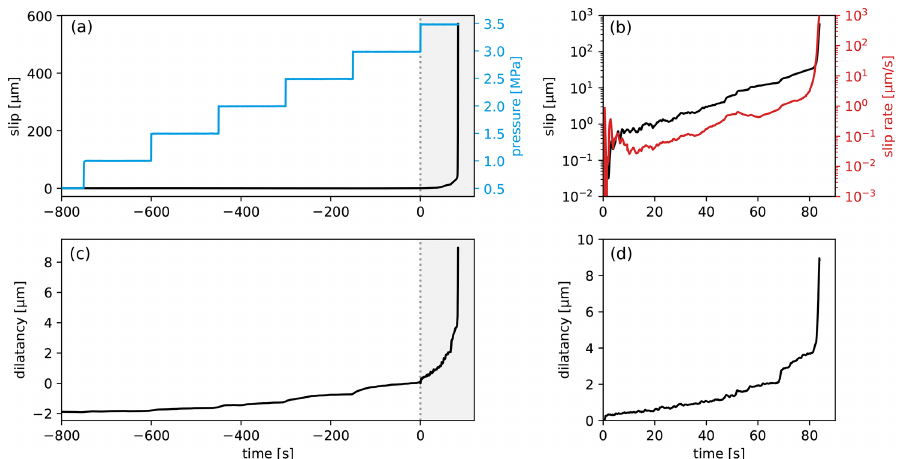
Figure 1. Overview of laboratory measurements of Cappa et al. (2019). The fault slip and dilatancy recorded over the full creep stage of the experiment are shown in (a) and (c) , respectively, along with the fluid pressure for reference. The final stage of the experiment (grey-shaded area of a and c ) is enlarged in (b) and (d) .